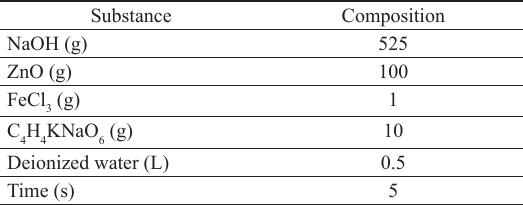
Table 2. Zincate treatment composition.